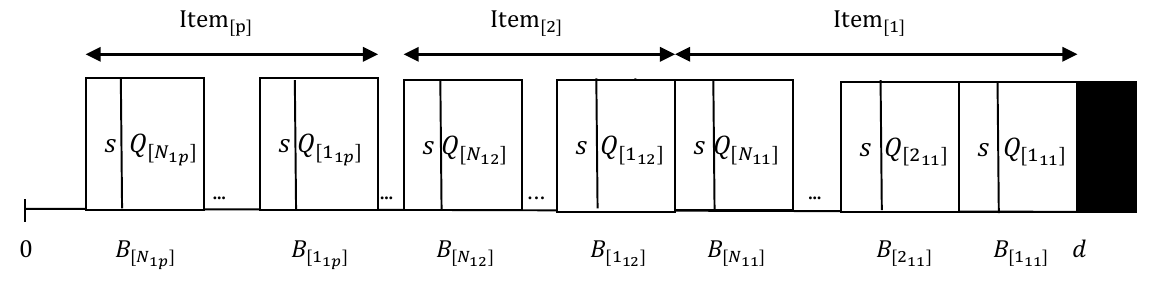
Fig. 1. Batches position in multiple items single machine with single production run in total actual flow time criteria